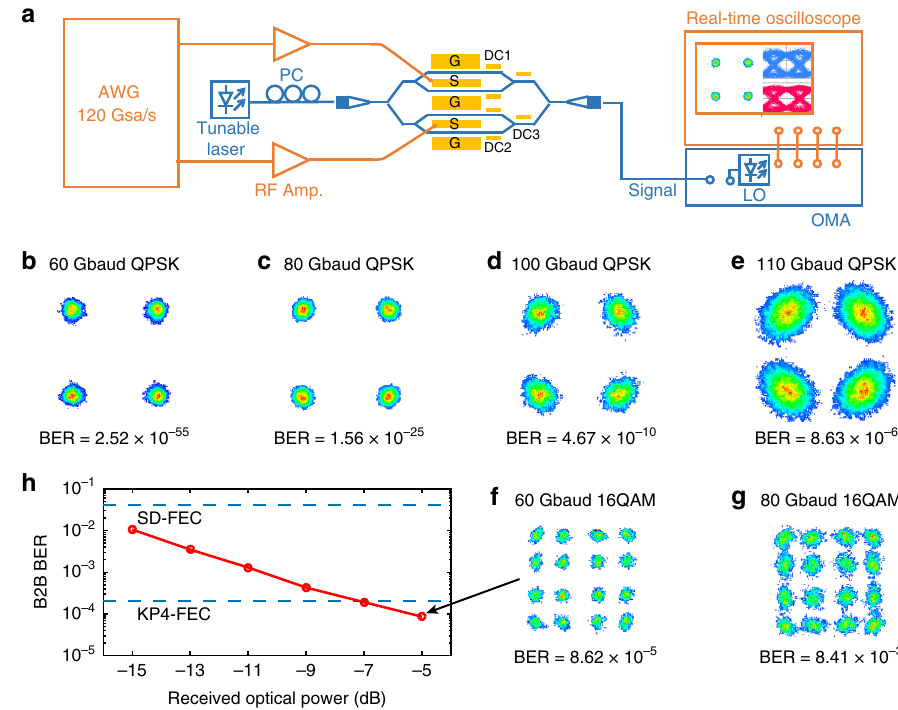
Fig. 5 Data modulation testing. a Experimental setup for coherent data transmission. AWG: arbitrary waveform generator, LO: local oscillator, OMA: optical modulation analyser, PC: polarisation controller. b – g Constellation diagram for QPSK signals with symbol rates of 60, 80, 100, and 110 Gbaud and 16 QAM signals with symbol rates of 60 and 80 Gbaud. h Measured curve of BER versus the received optical power for 60 Gbaud 16 QAM signal.